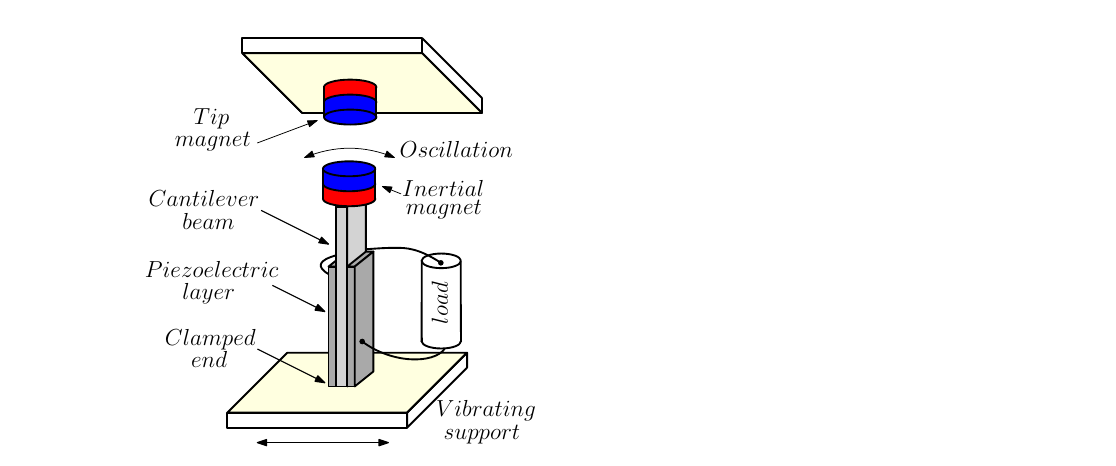
Figure 1. Schematic representation of a piezoelectric cantilever beam energy